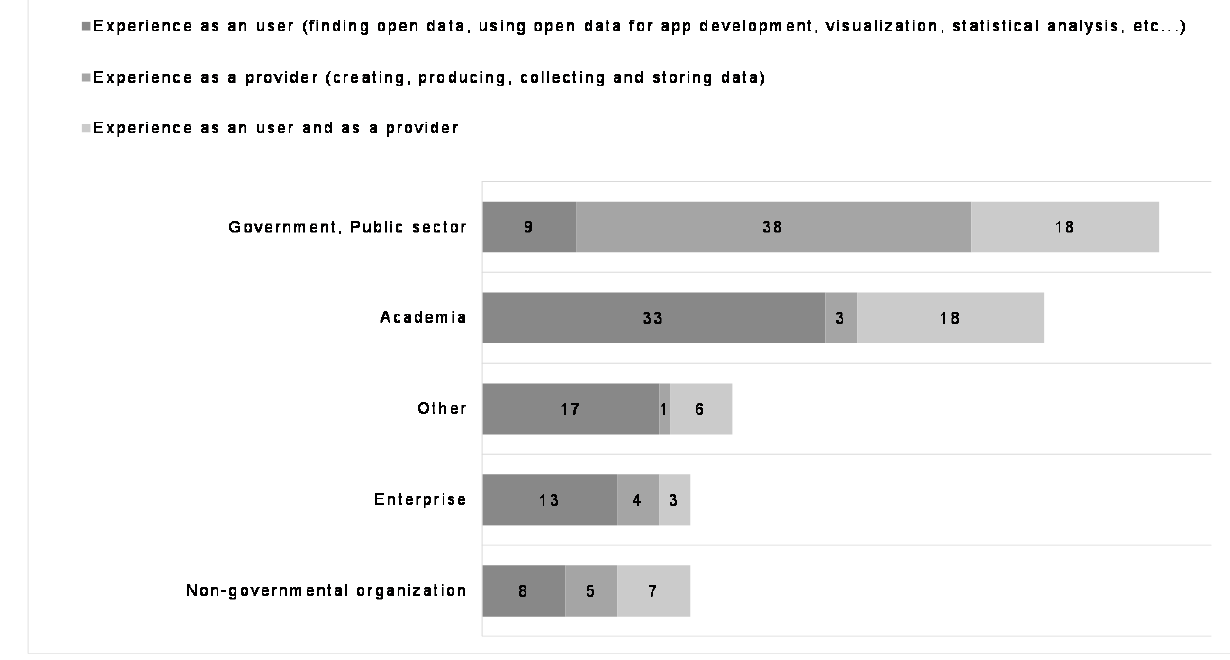
Figure 4: Types of Users and Types of Organizations (Source: